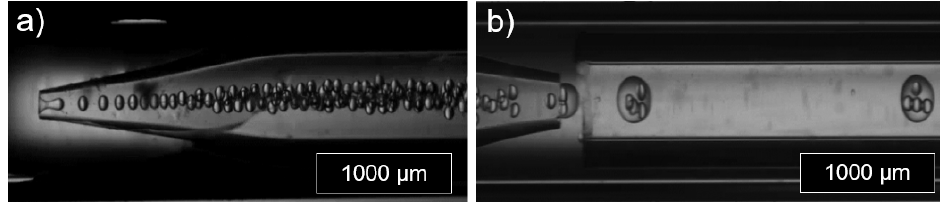
Figure 2. Production of W/O/W double emulsion droplets examined for coalescence in this work. ( a ) First break-up point. ( b ) Second break-up point. The flow rates were set to Q 1 = 0.5 mL/h and Q 2 = 3 mL/h at first break-up and Q 1 +